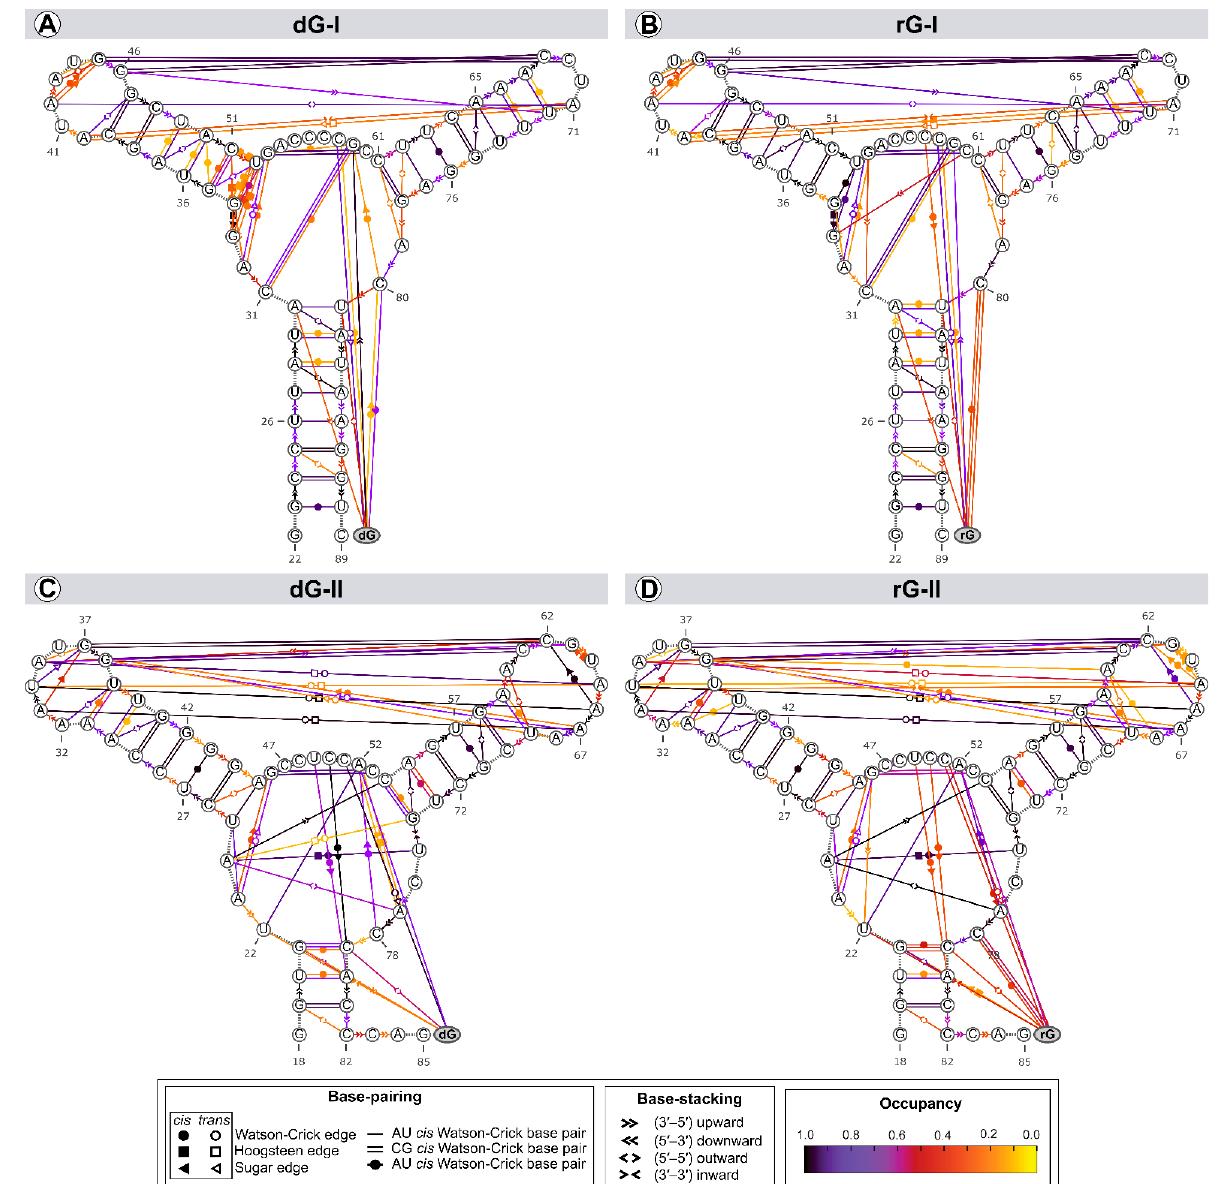
Figure 6. Dynamic secondary structure representation of 2′-dG-I ( A , B ) and 2′-dG-II ( C , D ) riboswitches classes bound to dG ( A , C ) and rG ( B , D ). The extended secondary structure annotation follows the Leontis-Westhof classification (see legend caption). The color scheme shows the fraction of frames (occupancy) within a system for which the interaction was formed.